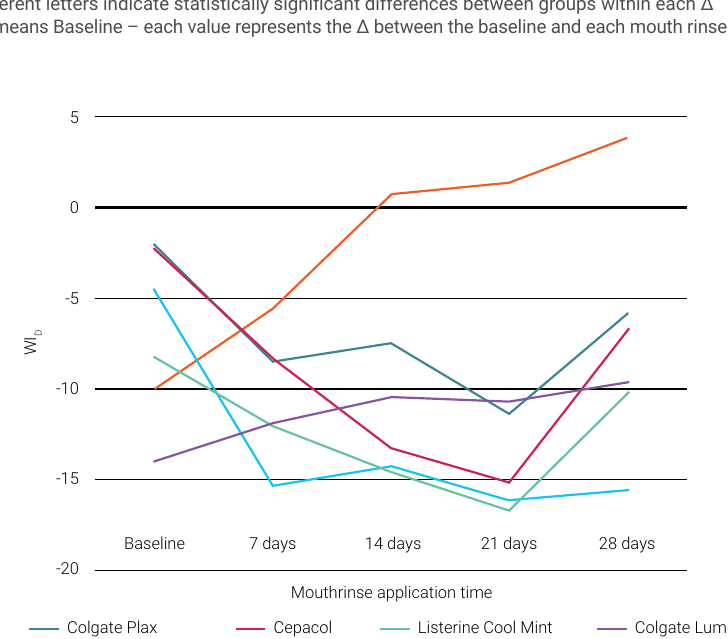
* Different letters indicate statistically significant differences between groups within each Δ ** B means Baseline – each value represents the Δ between the baseline and each mouth rinse application time